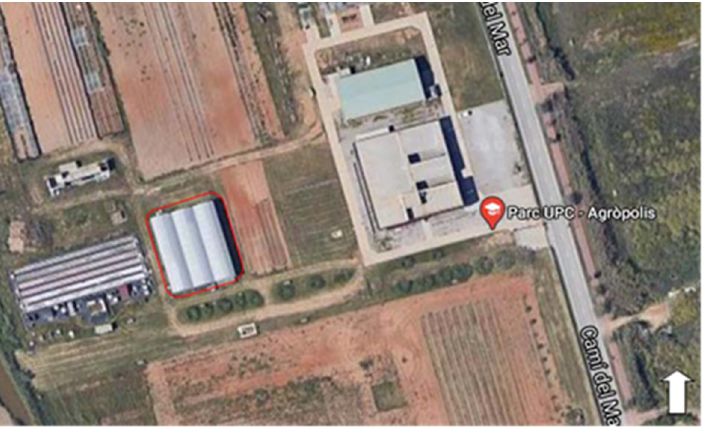
Figure 1. Satellite image of the experimental station of Agròpolis (The red box indicates the specific location of the research greenhouse).